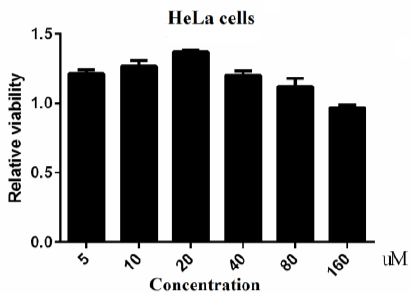
Figure 9. Cell viability of HeLa incubated with varying concentrations of probe S for 48 h.